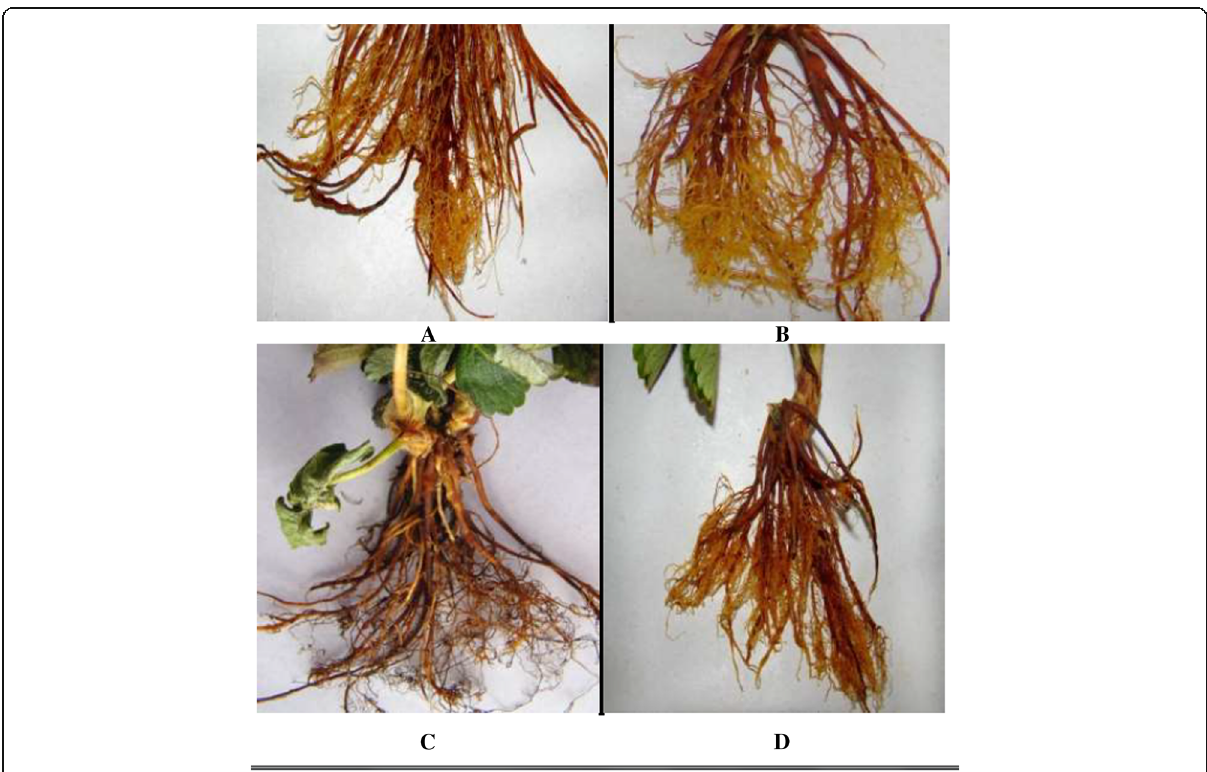
Fig. 2 Nematode galls on roots of four strawberry cultivars infected with Meloidogyne incognita . a K14. b Chandler. c Festival. d Sweet Charli (El-Habashy